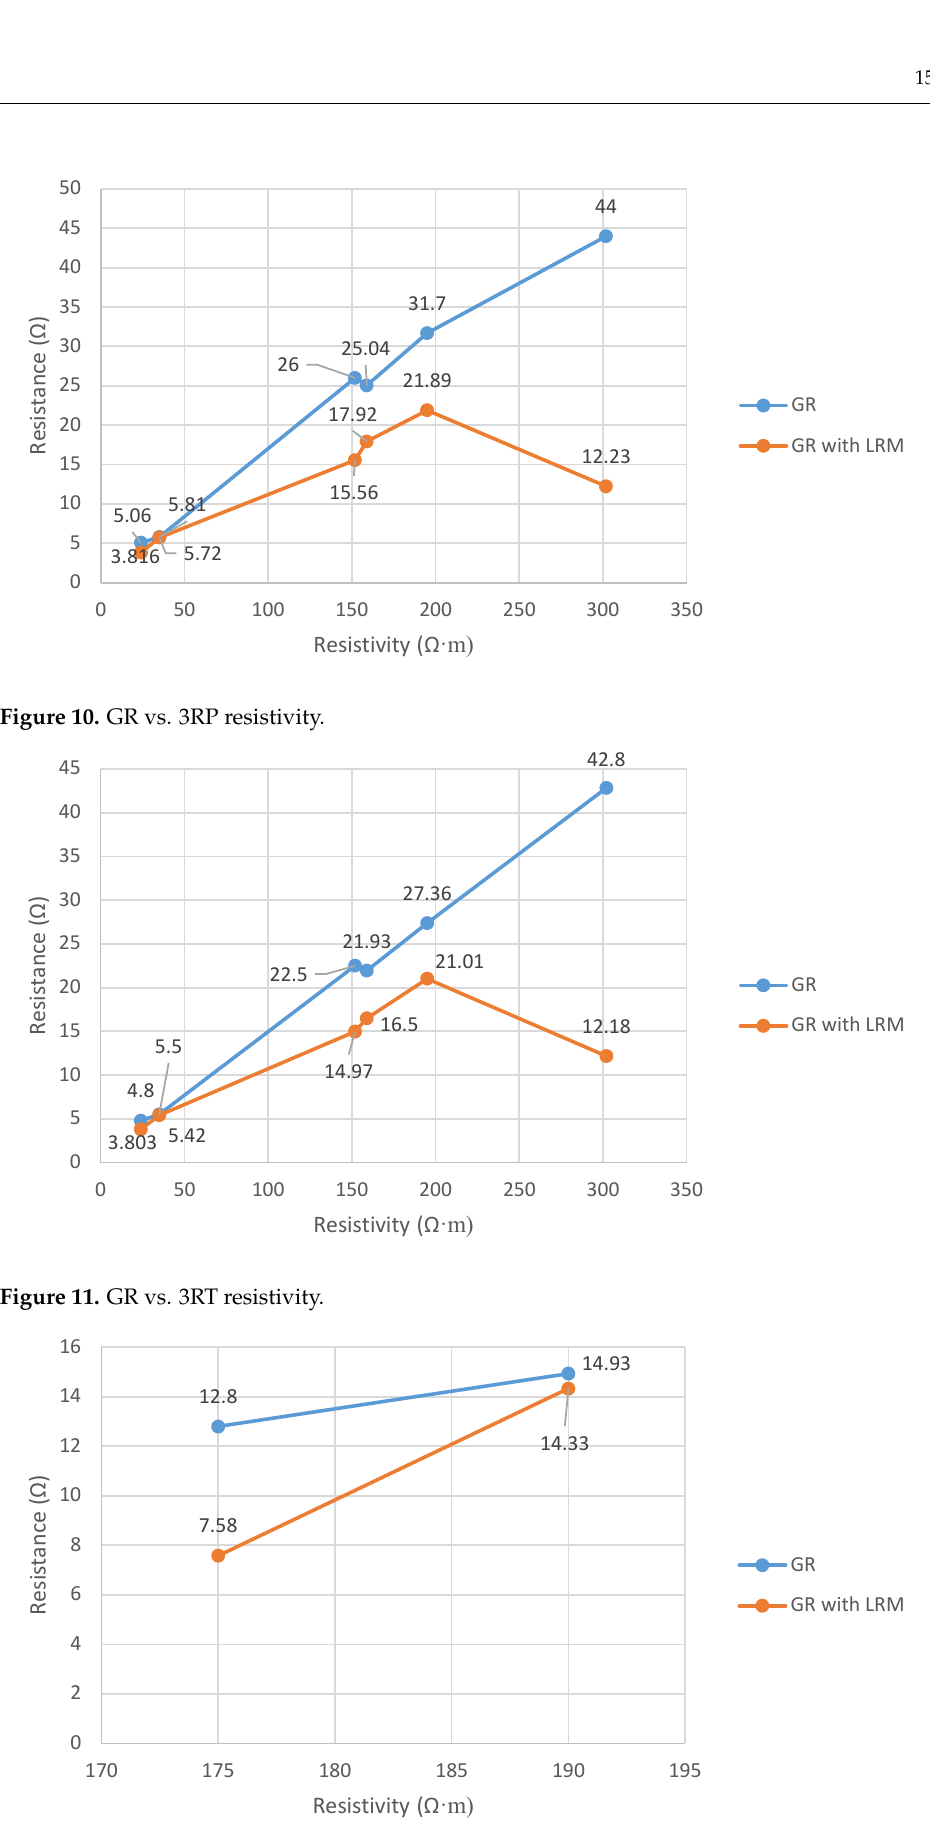
Figure 12. GR vs. 6RR